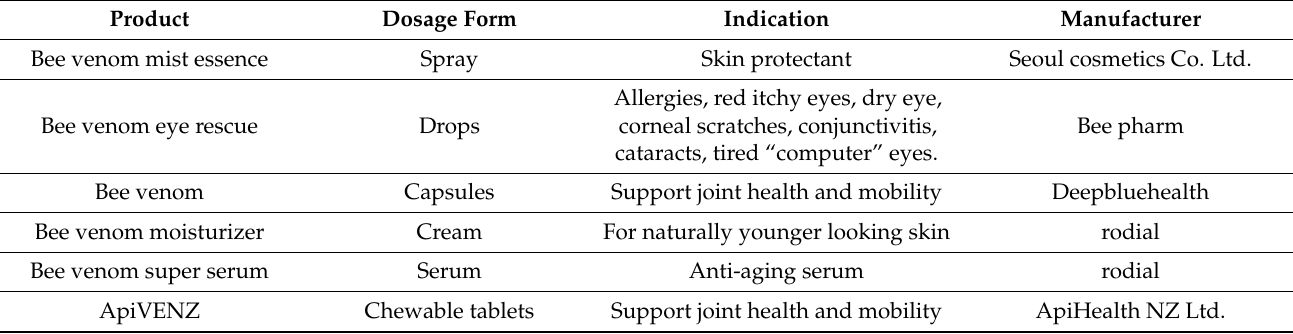
Table 3. Some products of bee venom available in